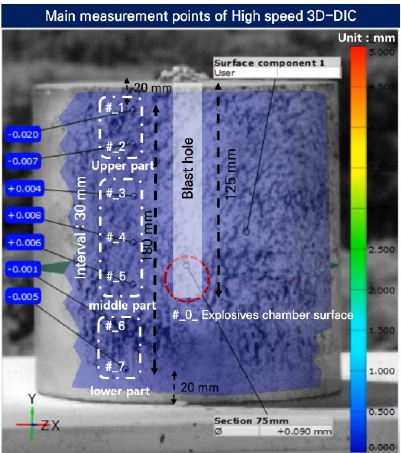
Figure 10. Schematic of measurement points of high ‐ speed 3D ‐ DIC.